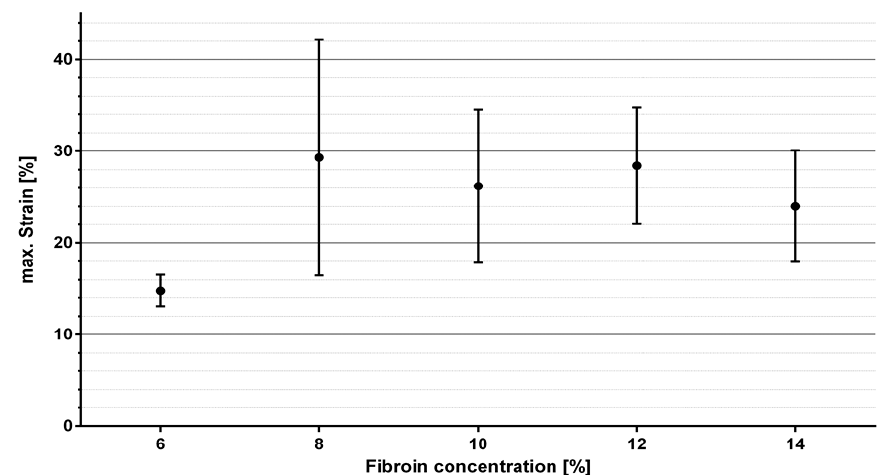
Figure 7. Mean value and standard deviation of maximum strain of the different membranes in relation to fibroin concentration.